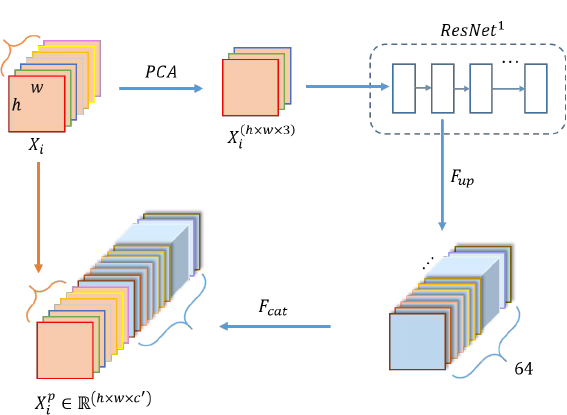
Figure 2. The pre-training process, and X ip is the output.